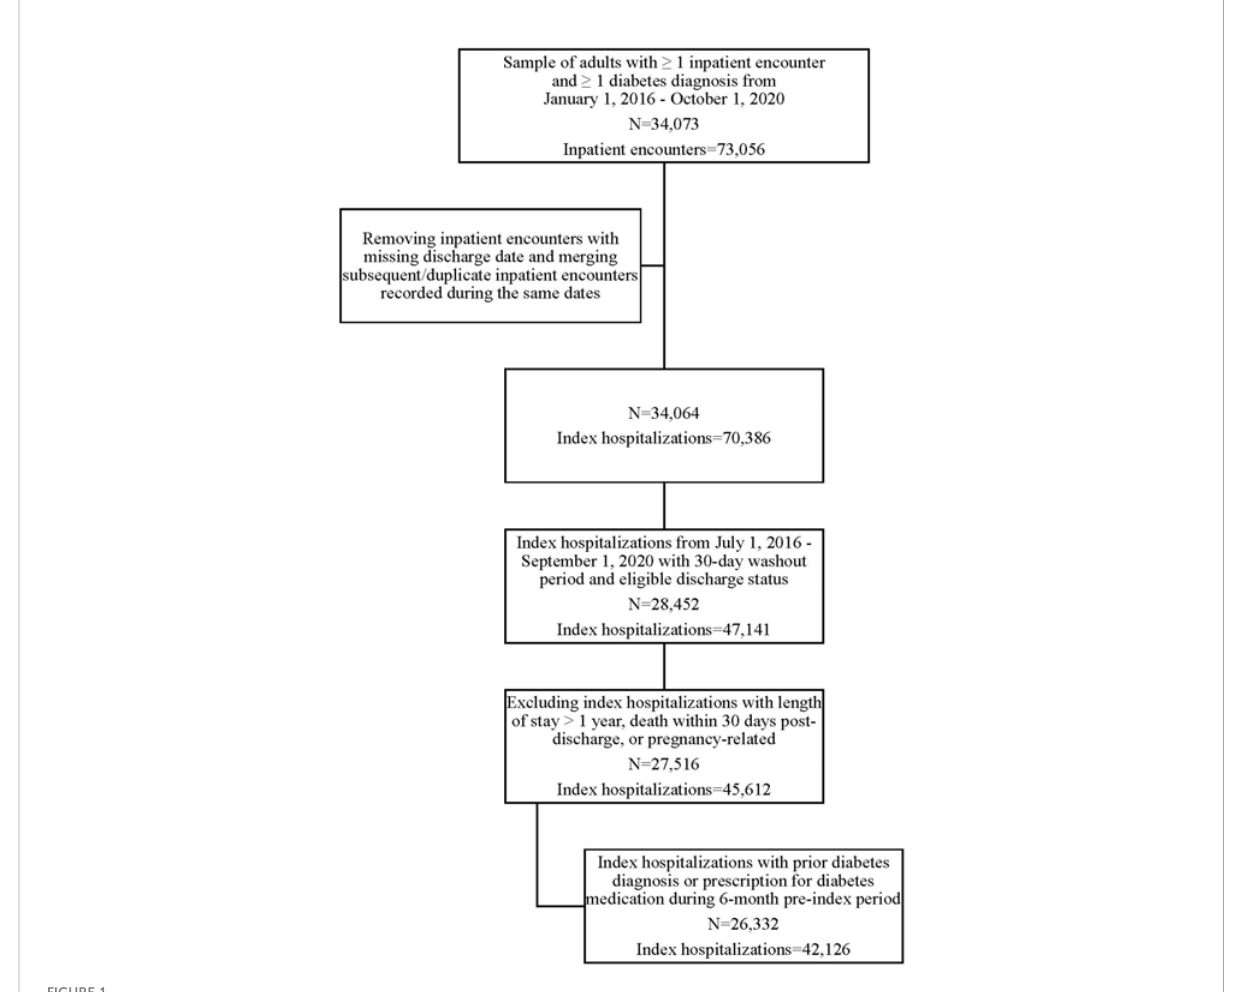
FIGURE 1 Flow diagram for cohort identi fi